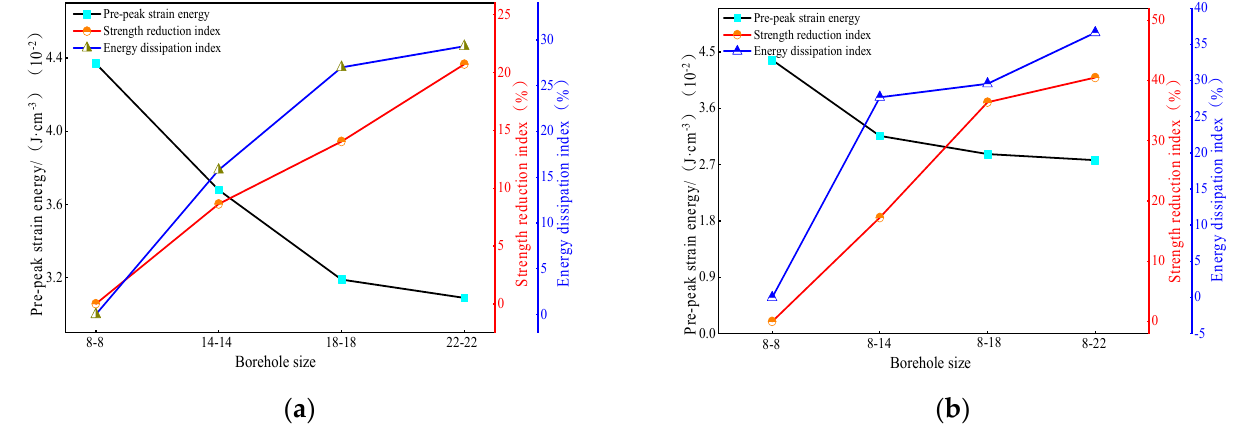
Figure 9. Post-peak mechanical characteristics of sample: ( a ) is the post-peak mechanical properties of samples drilled in the same diameter; ( b ) is post peak mechanical properties of variable-diameter drill samples. Table 2. Post-peak mechanical parameters of each sample under different borehole sizes. Sample